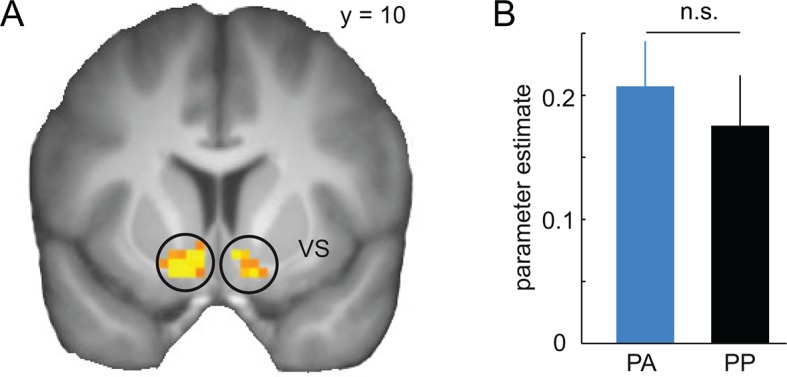
Prediction error responses in the ventral striatum during discrimination training.(A) Regions in the ventral striatum (VS, left, x = -15, y = 8, z = -16, t = 6.97, P < 0.001, FWE whole brain corrected; right, x = 6, y = 14, z = -10, t = 6.22, P = 0.003, FWE whole brain corrected) in which activity is correlated with model-derived prediction errors (PE) during the training session across both groups. T-map from one-sample t-test (across the two groups) is thresholded at P < 0.05, FWE whole brain corrected and overlaid on a T1-weigthed image averaged across subjects. (B) Bar plots depict parameter estimates for PE-related activity in the VS. Given that both groups received placebo during the training session, neural PE-responses were not expected to differ, and indeed did not differ between groups (two-sample t-test, t = 0.58, P = 0.56). Error bars are SEM for N = 25 (PA) and N = 21 (PP).